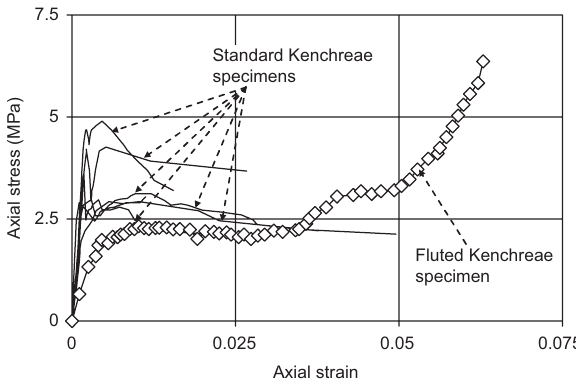
Figure 17 Comparison between standard and fl uted specimens from Kenchreae